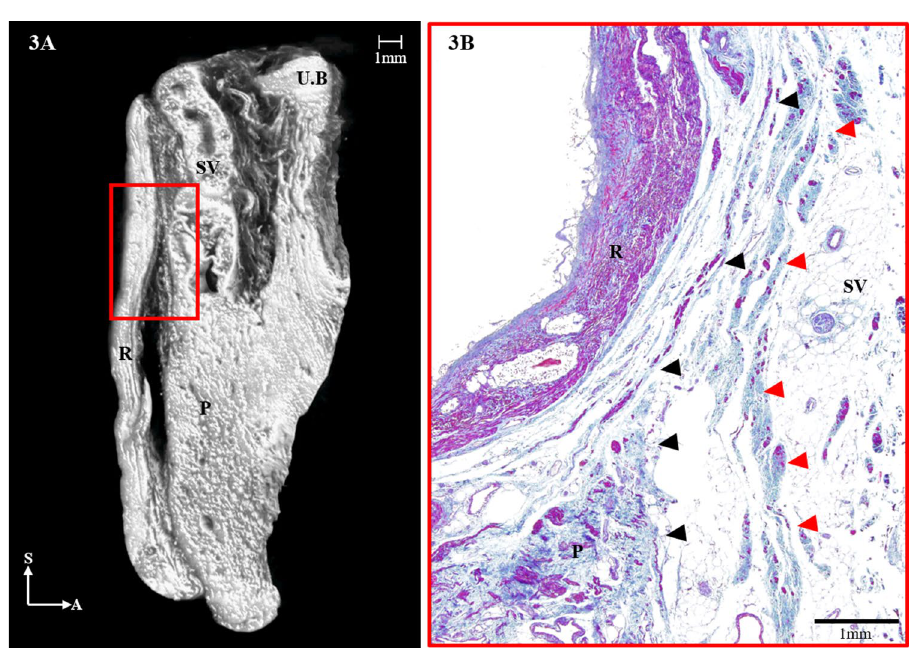
Figure 3. ( A ) Three-dimensional anatomy of the Denonvilliers’ fascia (DVF; red) from a sagittal section reconstructed from micro-computed tomography. ( B ) The distal, seminal part of the DVF is shown diverging to the anterior sheet and merging with the prostatic capsule (red arrowheads) and the posterior sheet (black arrowheads), covering the rectum. UB, urinary bladder; SV, seminal vesicle; P, prostate; R, rectum; S, sagittal; A,